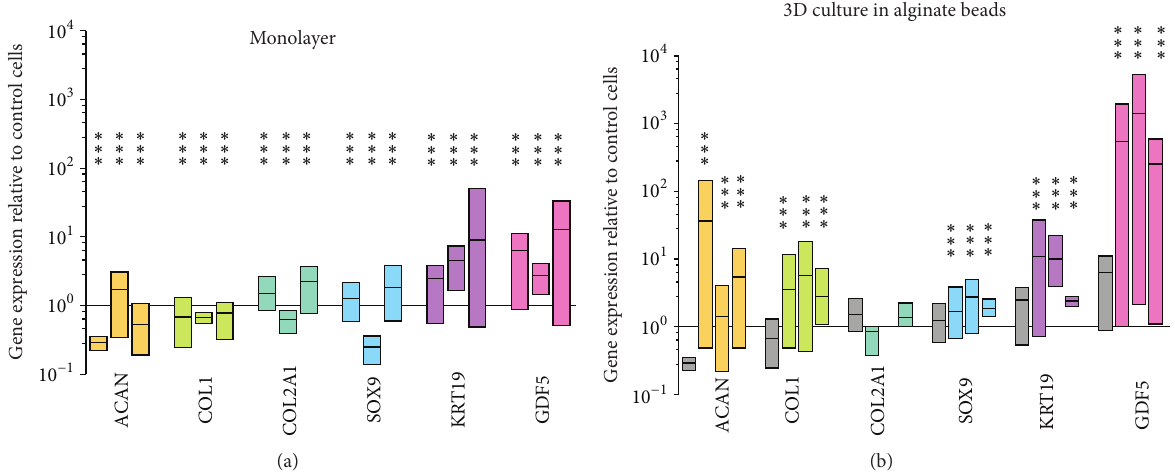
Figure 3: Relative gene expression to untransfected cells after 7, 14, and 21 days (three time points) in monolayer culture (a) and (b) in 3D cell culture using 1.2% alginate beads; gray bars correspond to state of day 0 cells (day 7 in monolayer culture). Bars represent min. to max. with a line at the mean. N = 4 ± SEM. ∗∗∗ denotes significantly different from 1 (untransfected cells) with 𝑃 < 0.0001